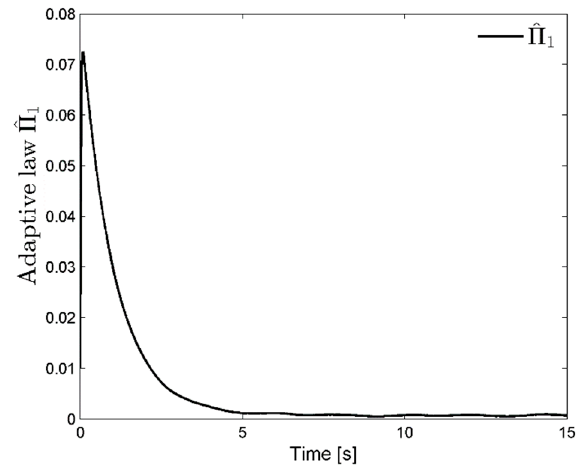
ˆ Π . Figure 7. Trajectory of adaptive law ˆ Π 1 . 1